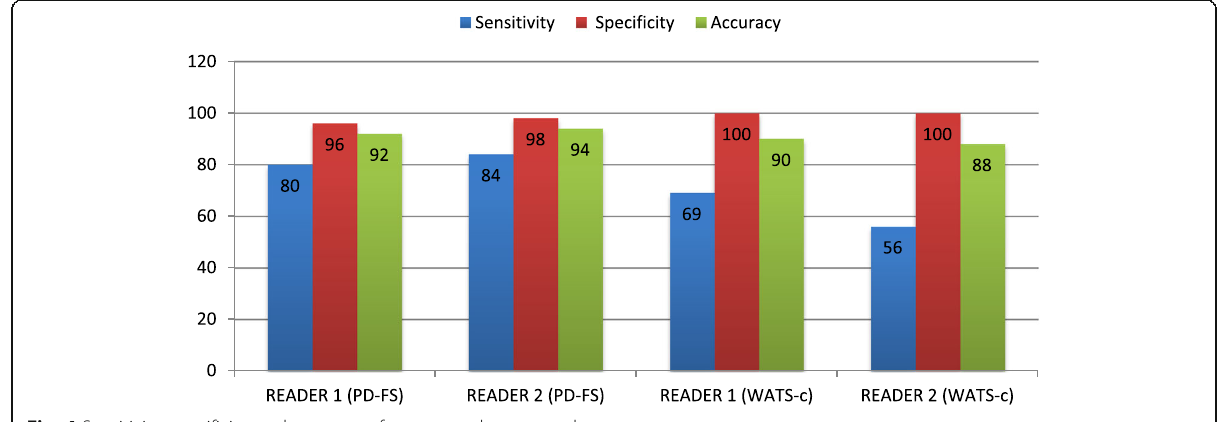
Fig. 4 Sensitivity, specificity, and accuracy of sequences by two